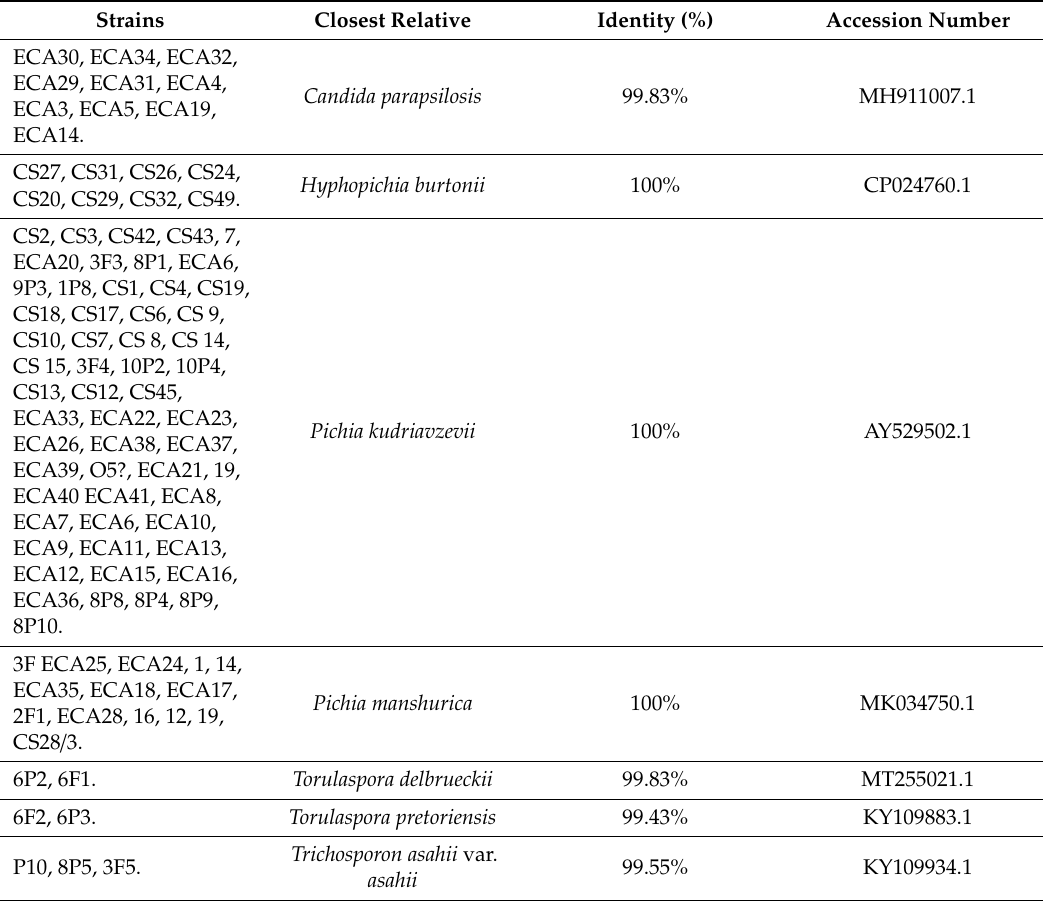
Table 2. Identification of the yeast isolates determined by partial (D1 / D2 loop) 26S rRNA encoding gene sequence